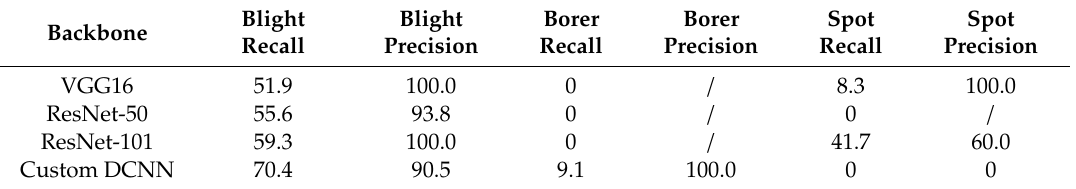
Table 7. Video metrics of backbones with pre-trained models using Video 1 (%) 1 . Video 1 is illuminated in Section